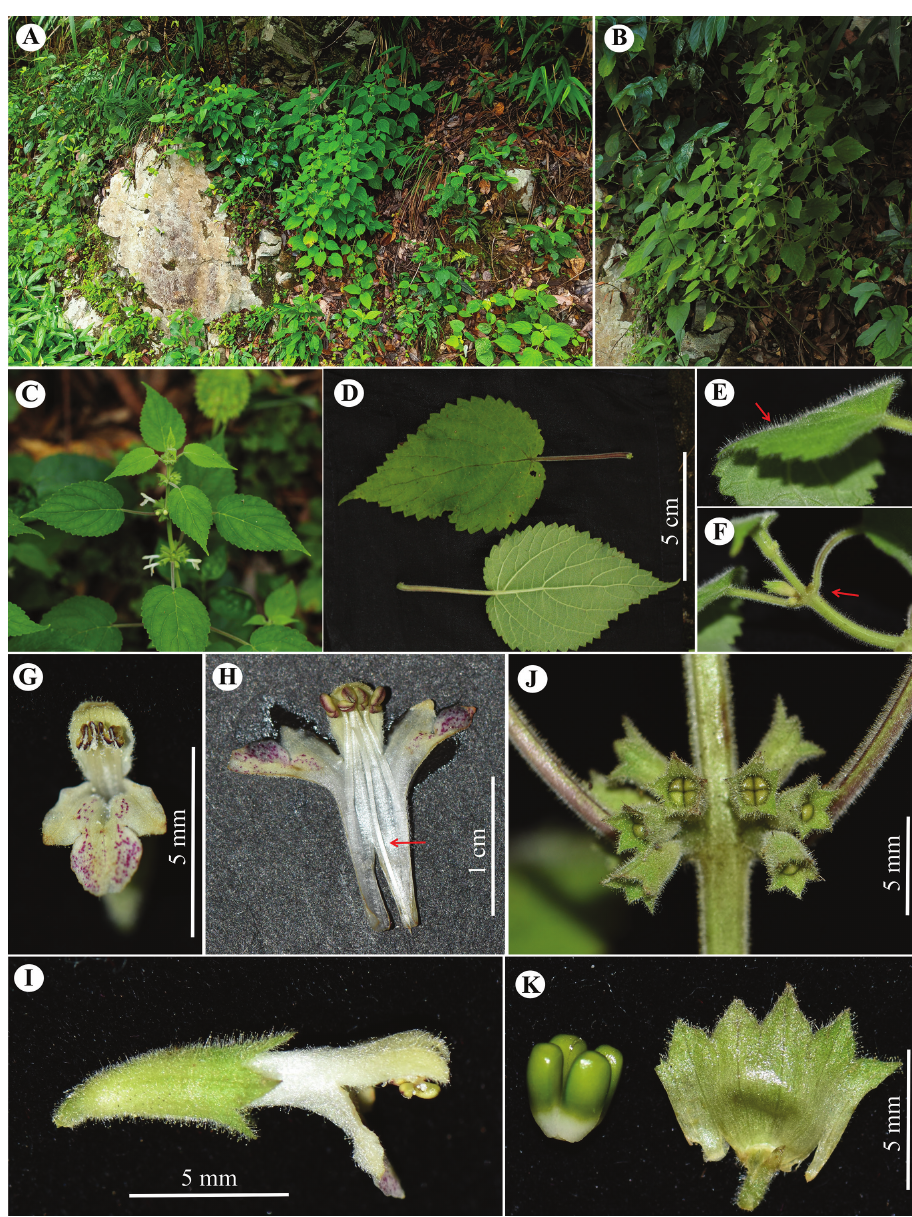
Figure 2. Paraphlomis jinggangshanensis A habit, growing on gravelly hillside B plant, stems much branched C flowering branch D leaves with long petiole, base cordate E both surfaces of leaf blade with dense glandular trichomes F stem, petiole, and calyx tube with dense glandular trichomes G front view of corolla, lower lip dotted with purplish red spots, throat villous annulate H inner view of corolla, fila- ments borne in middle of corolla tube; red arrow indicates glabrous style; anthers glabrous I lateral view of flower J inflorescence K fresh nutlets (glabrous) and inner view of calyx tube ( A–D by Zhong Zhang E–K by Wan-Yi